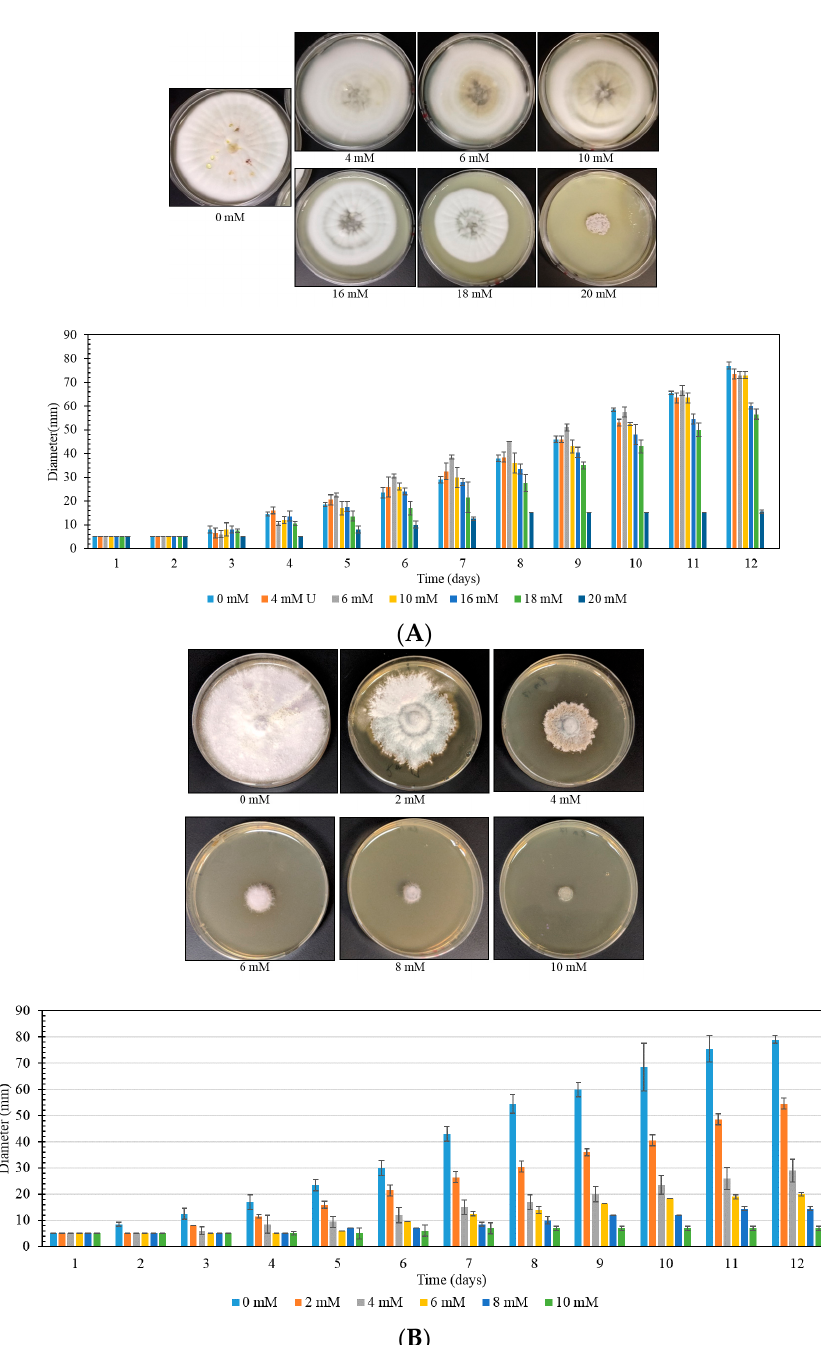
Figure 5. The MIC determination of fungal strains SRS-40-S-2018 ( A ) and SRS-17-S-2019 ( B ), using plate MIC method. Plate images were taken after 12 days of incubation, at 30 °C. The histogram represents the diameter of fungal growth, and measurements were taken on every day, up to 12 days. The experiments were performed in duplicate, and error bars are shown in standard deviation.